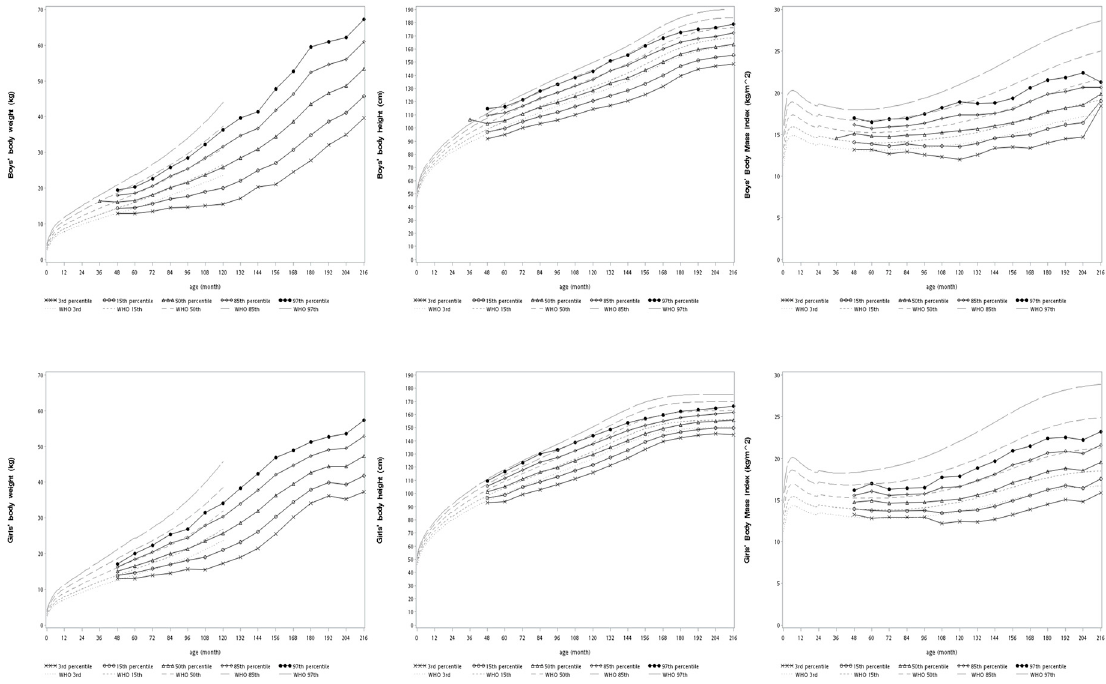
Figure 3. Growth curves of BW, BH, and BMI superimposed on the WHO standards (BW: body weight, BH: body height, BMI: body mass index).